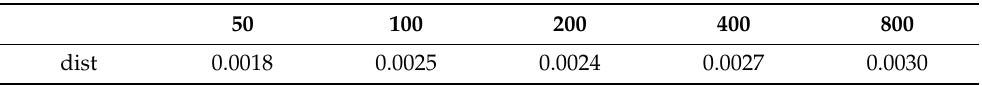
Figure 8. Surface meshes of the estimated mean ape cranium generated using different semi- landmarking approaches after re-semilandmarking and re-warping. ( a ) Sliding TPS. ( b ) TPS&NICP. ( c ) LS&ICP.